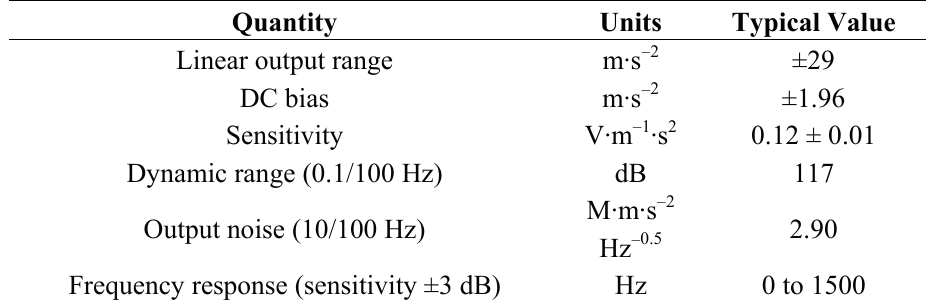
Table 1. Micro Electro-Mechanical System (MEMS) accelerometer